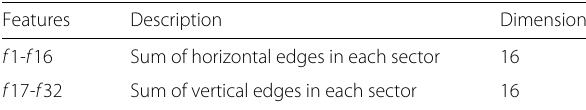
Table 2 Summary of features employed for clustering